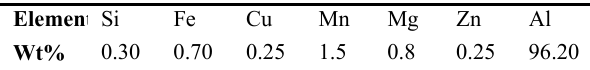
Table. 1. Nominal chemical composition of the aluminum alloy